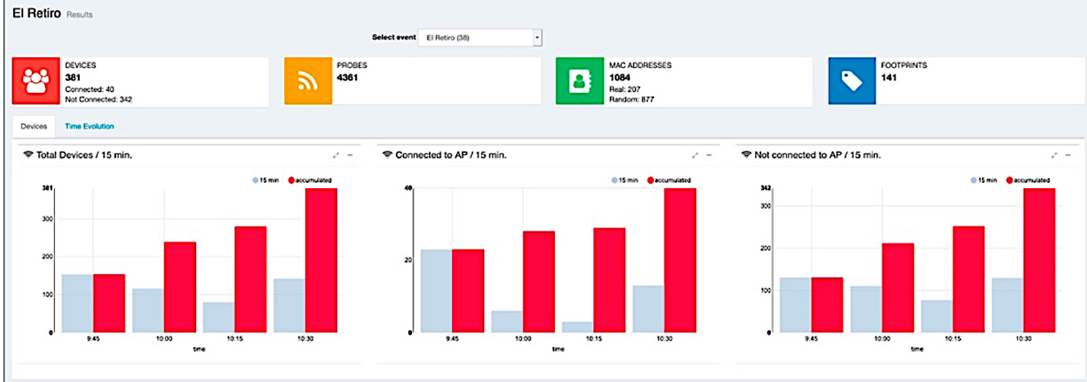
Figure 10. Graphical view of the occupancy of a space where an event is organized.